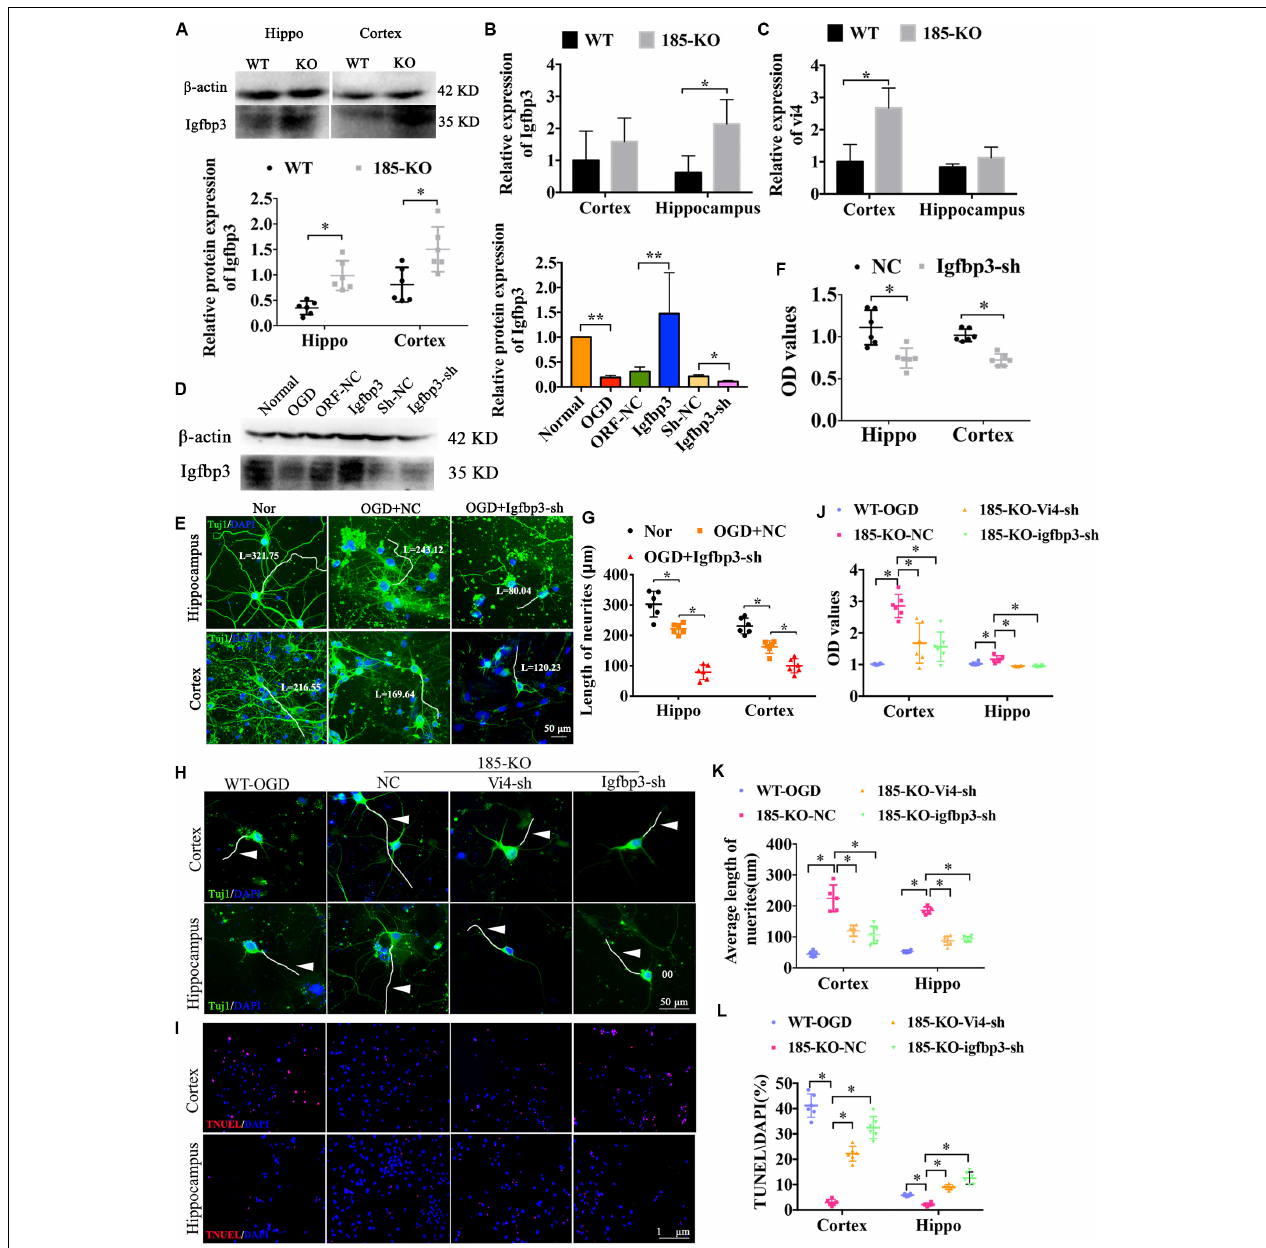
FIGURE 6 | The role of miRNA-185-5p KO in the growth of neurons and cell apoptosis as well as the regulatory relationship with Vi4 and Igfbp3 in function. (A) Western blot detection of the expression of Igfbp3 protein in the cortical and hippocampal brain tissues of the WT and 185-KO rats, n = 6/group. The relative expression was relative to that of the 185-WT in hippocampus group. (B,C) The expression of Igfbp3 and Vi4 in cortex and hippocampus from WT and 185-KO rats. The relative expression was relative to that of the 185-WT in cortex group. (D) Western blot detection of the expression of Igfbp3 protein in the cortical neurons in the groups of normal, OGD, NC, Igfbp3 and Igfbp3-sh. The relative expression was relative to that of the sham or normal group. (E,G) Immunofluorescent staining of Tuj1 in Nor, OGD + NC, and OGD + Igfbp3-sh groups to detect the cell phenotype and axon growth. The neurons are stained by green colors, which are Tuj1 positive. Blue represents the nucleus. Scale bar = 50 µ m. (F) Relative CCK8 values in the cortical and hippocampal neurons between NC and Igfbp3-si groups, n = 6/group. (H) Immunofluorescent staining of Tuj1 in the cortical and hippocampal neurons, respectively, in the groups of WT, miR-185-5p-KO + NC (185-KO-NC), miR-185-5p-KO + Vi4-sh (185-KO-Vi4-sh) and miRNA-185-5p-KO + Igfbp3-sh (185-KO-Igfbp3-sh) 24 h after OGD. Scale bar = 50 µ m, green staining represents the Tuj1 positive cells, and the nucleus s stain d by blue. White arrow represents axon. (I) TUNEL staining in the WT, miR-185-5p-KO + NC (185-KO-NC), miR -185- 5p-KO + Vi4-sh (185-KO-Vi4-sh) and miRNA-185-5p-KO + Igfbp3-sh (185-KO-Igfbp3-sh) groups 24 h after OGD in both cortical and hippocampal neurons. Scale bar = 100 µ m. Apoptotic cells are stained by red color, and the nucleus is stained by blue. (J–L) Quantitative histograms of relative CCK8 values, the average length of axon and cell apoptosis presented by TUNEL/DAPI (%). Nor, normal; Vi4-sh, Vi4-shRNA, interference of Vi4 by shRNA; Igfbp3-sh, interference of Igfbp3 by shRNA. All data are shown as mean ± SD, ∗ P < 0.05, ∗∗ P < 0.01, n = 6/group.